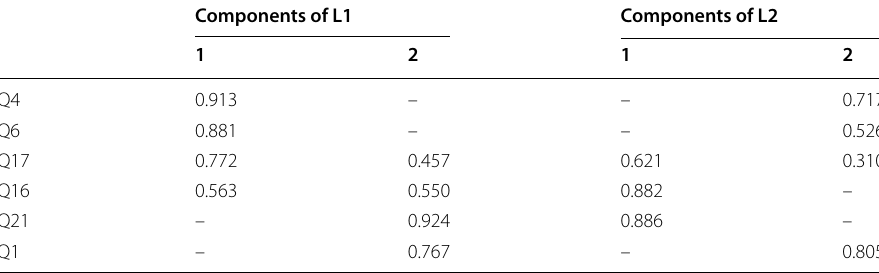
Table 11 Component matrix for L1 and L2 Use with Others Components of L1 Components of